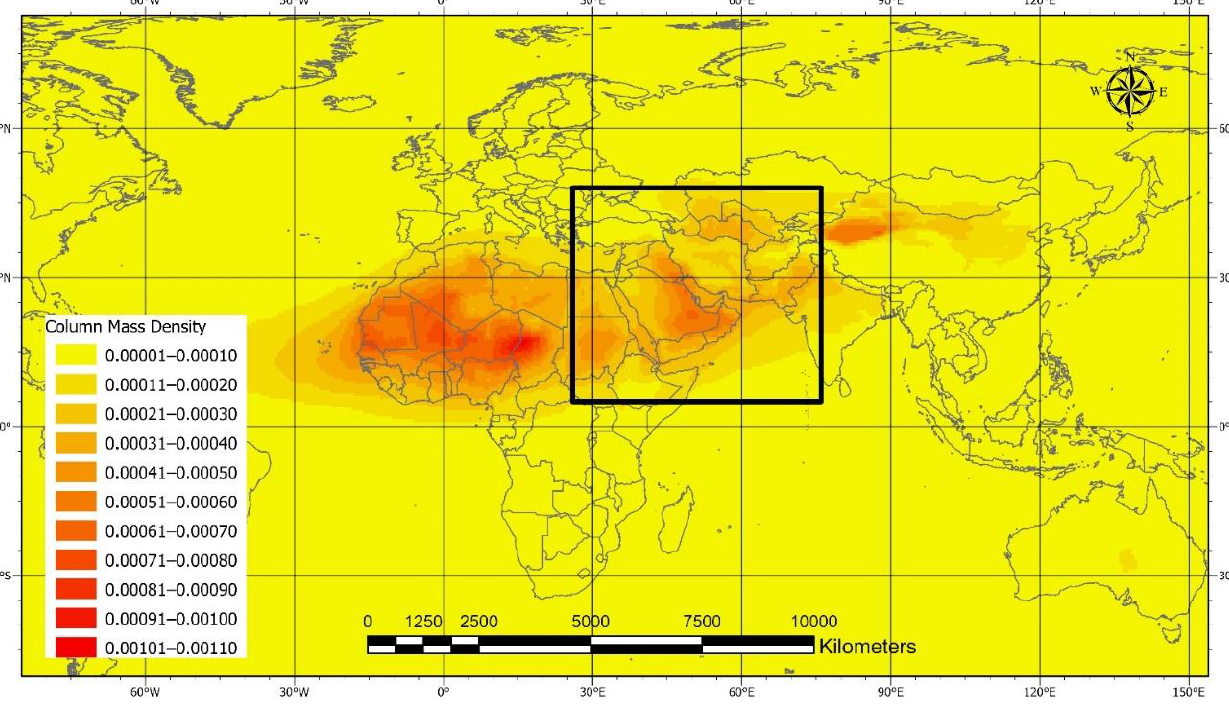
Figure 1. MERRA-2 long-term mean dust column mass density (unit: kg m −2 ) during 1980-01 to 2021- 12. Data were obtained from NASA GIOVANNI in GEOTIFF format (https://gio- vanni.gsfc.nasa.gov/giovanni/#service=TmAvMp&starttime=1980-01-01T00:00:00Z&endtime=2021- 12-31T23:59:59Z&data=M2TMNXAER_5_12_4_DUCMASS ( accessed on 11 August 2022)). The black box is the Key Region (5 – 48° N, 26 – 76° E) which was defined in Huang et al. [23].